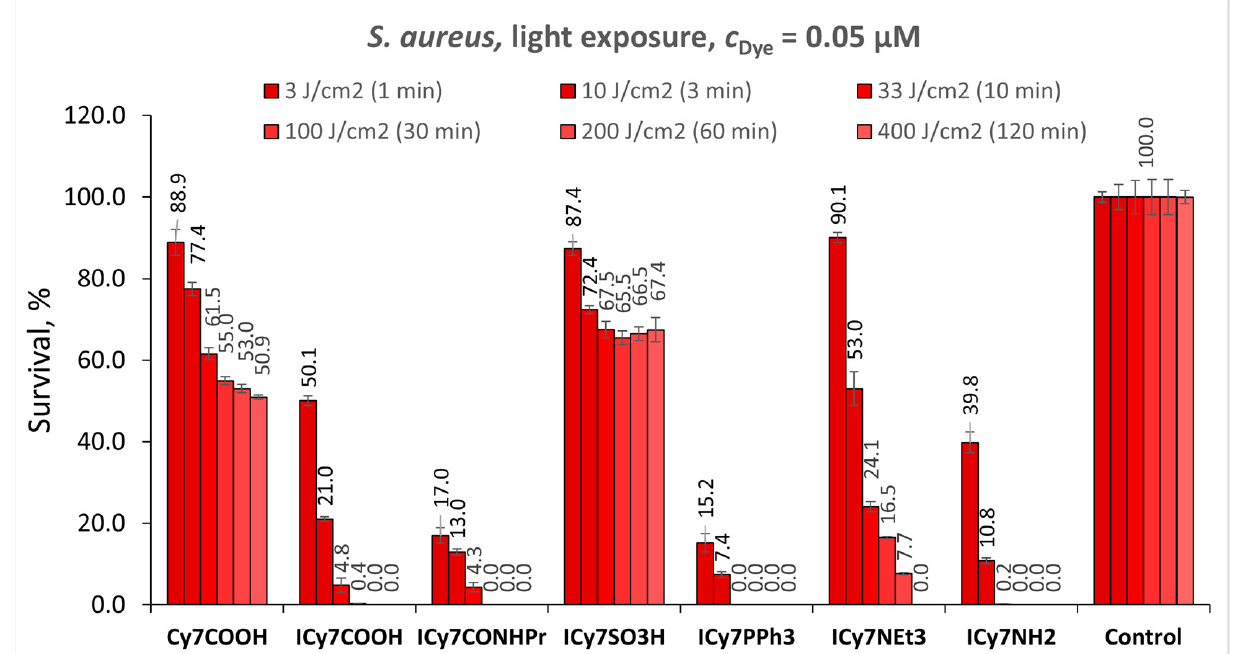
Figure 4. Survival of S. aureus at ( c Dye = 0.05 µM in saline containing 0.7% DMSO), when exposed to 3 J/cm 2 (1 min), 10 J/cm 2 (3 min), 33 J/cm 2 (10 min), 100 J/cm 2 (30 min), 200 J/cm 2 (60 min), and 400 J/cm 2 (120 min) light doses.